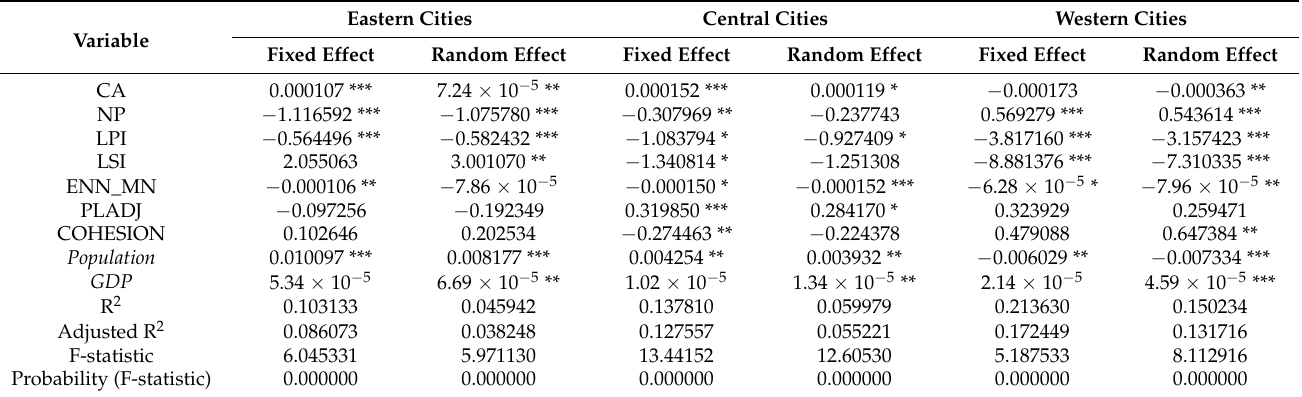
Table 7. The relationships between the UF and PM 2.5 concentration in the different regions at the city scale. Eastern Cities Central Cities Western Cities Variable Fixed Effect Random Effect Fixed Effect Random